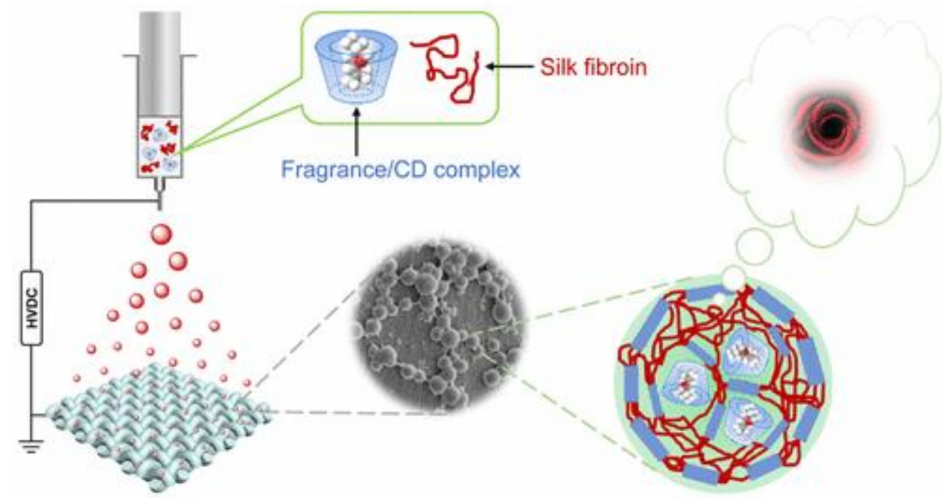
Figure 2. Direct deposition of fragrance-loaded nanoparticles onto fabric surfaces by electro-spraying (reproduced from [113]). CD: